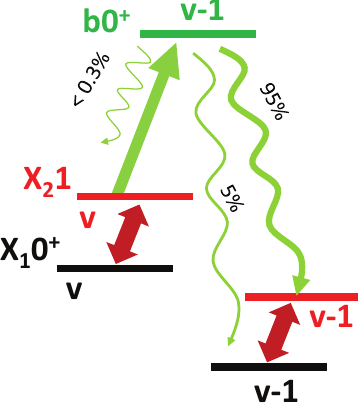
Figure 6. Vibrational cooling. Straight arrows indicate transitions covered by lasers, and wavy arrows indicate spontaneous emission